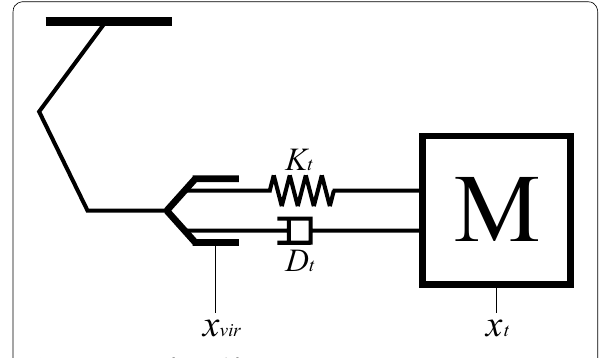
Fig. 6 Concept of virtual